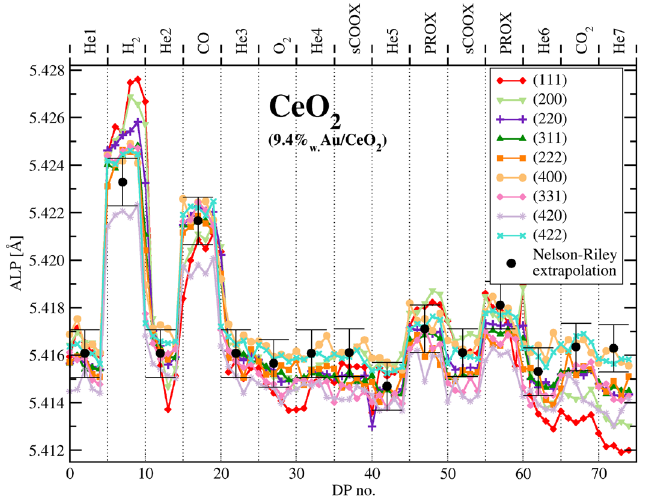
Figure 7. Apparent lattice parameter (ALP) as derived from a number of ceria peaks of the catalyst corrected for the temperature light-off